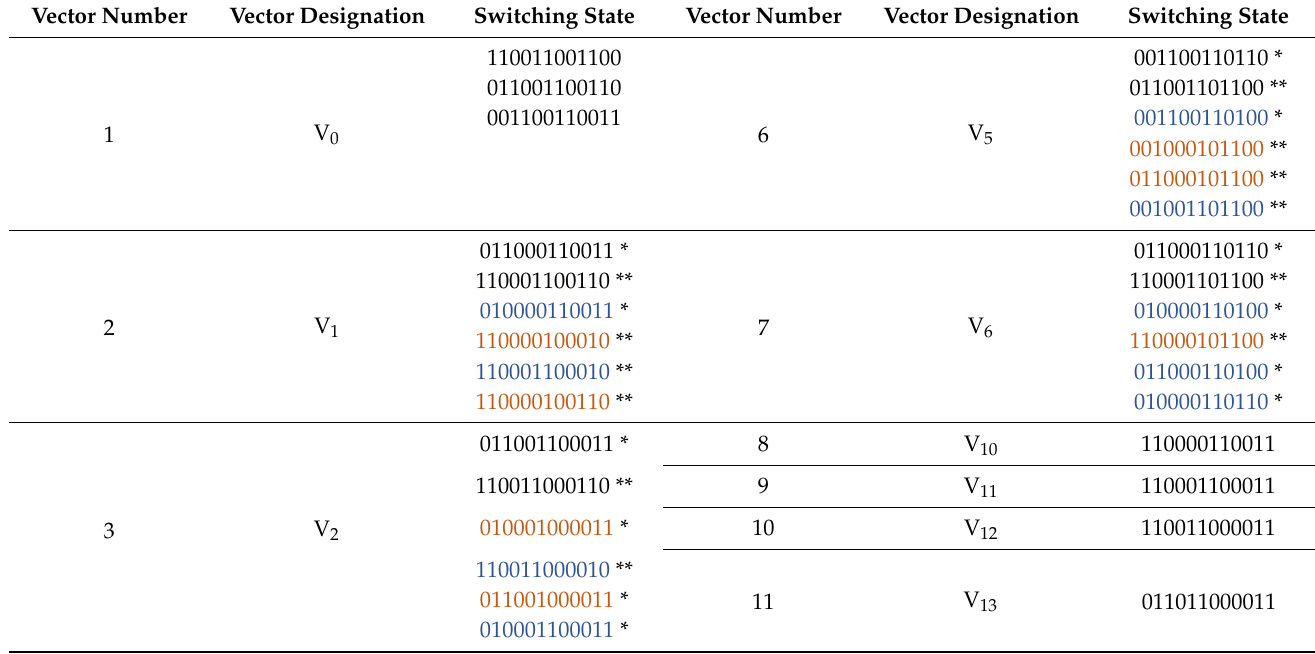
Table 1. The switching states of the 3L-NPC inverter corresponding to the voltage vectors. The switching states are described as a 12-bit number in T1–T12 order; 0—OFF, 1—ON, *—loads C2, **—loads C1. Vectors V 10 to V 21 load all capacitors. Black—commonly used switching states of redundant voltage vectors; blue and orange—additional switching states; orange—switching states that do not allow flow of current both in and out of the neutral phase leg of the inverter.